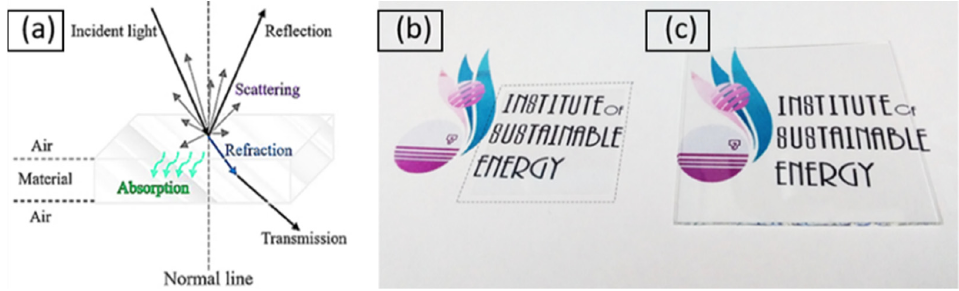
Figure 3. ( a ) Transmitted/reflected and absorbed rays, ( b ) UTG, and ( c ) 1.1 mm borate glass.